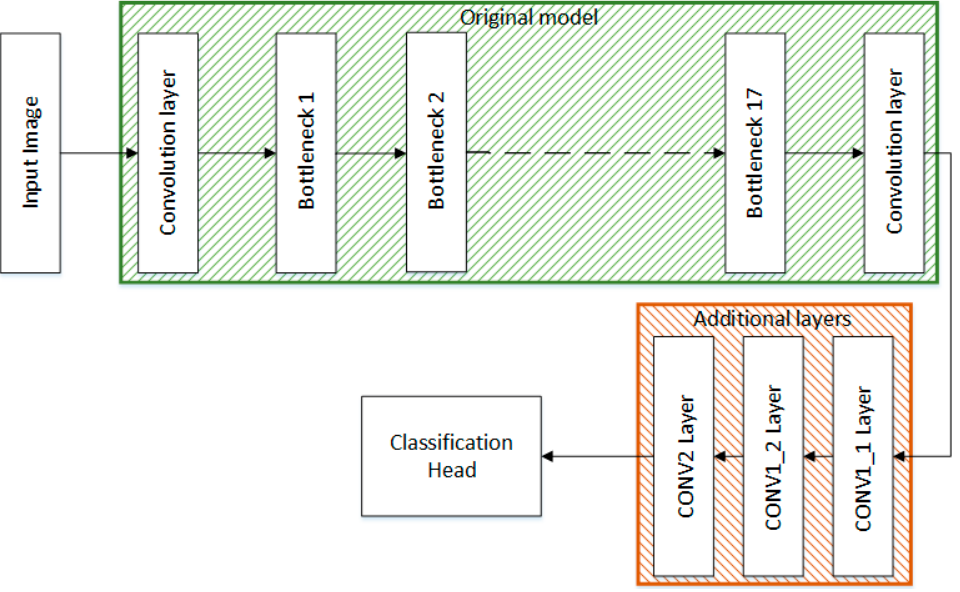
Figure 4. Architecture of the proposed modified MobileNetV2.